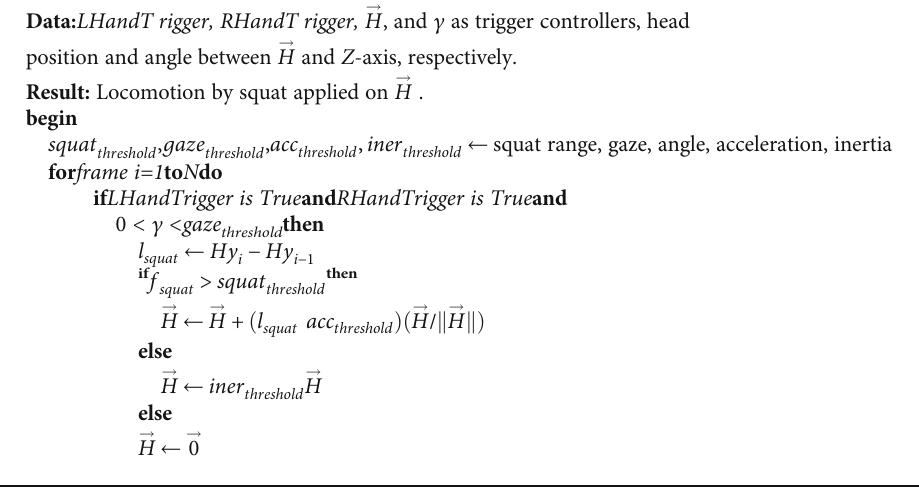
Algorithm 2: Squat virtual